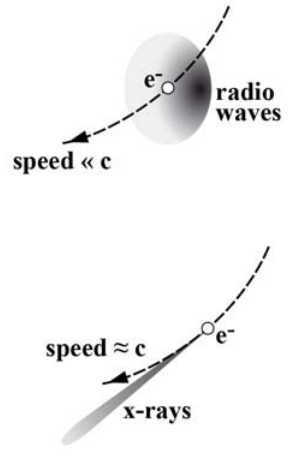
Figure 2. Synchrotron light emission in the nonrelativistic (top) and relativistic cases. When the electron speed in the storage ring approaches the speed of light, the emission is strongly peaked in the forward direction and centered in the x-rays region rather than consisting of radio